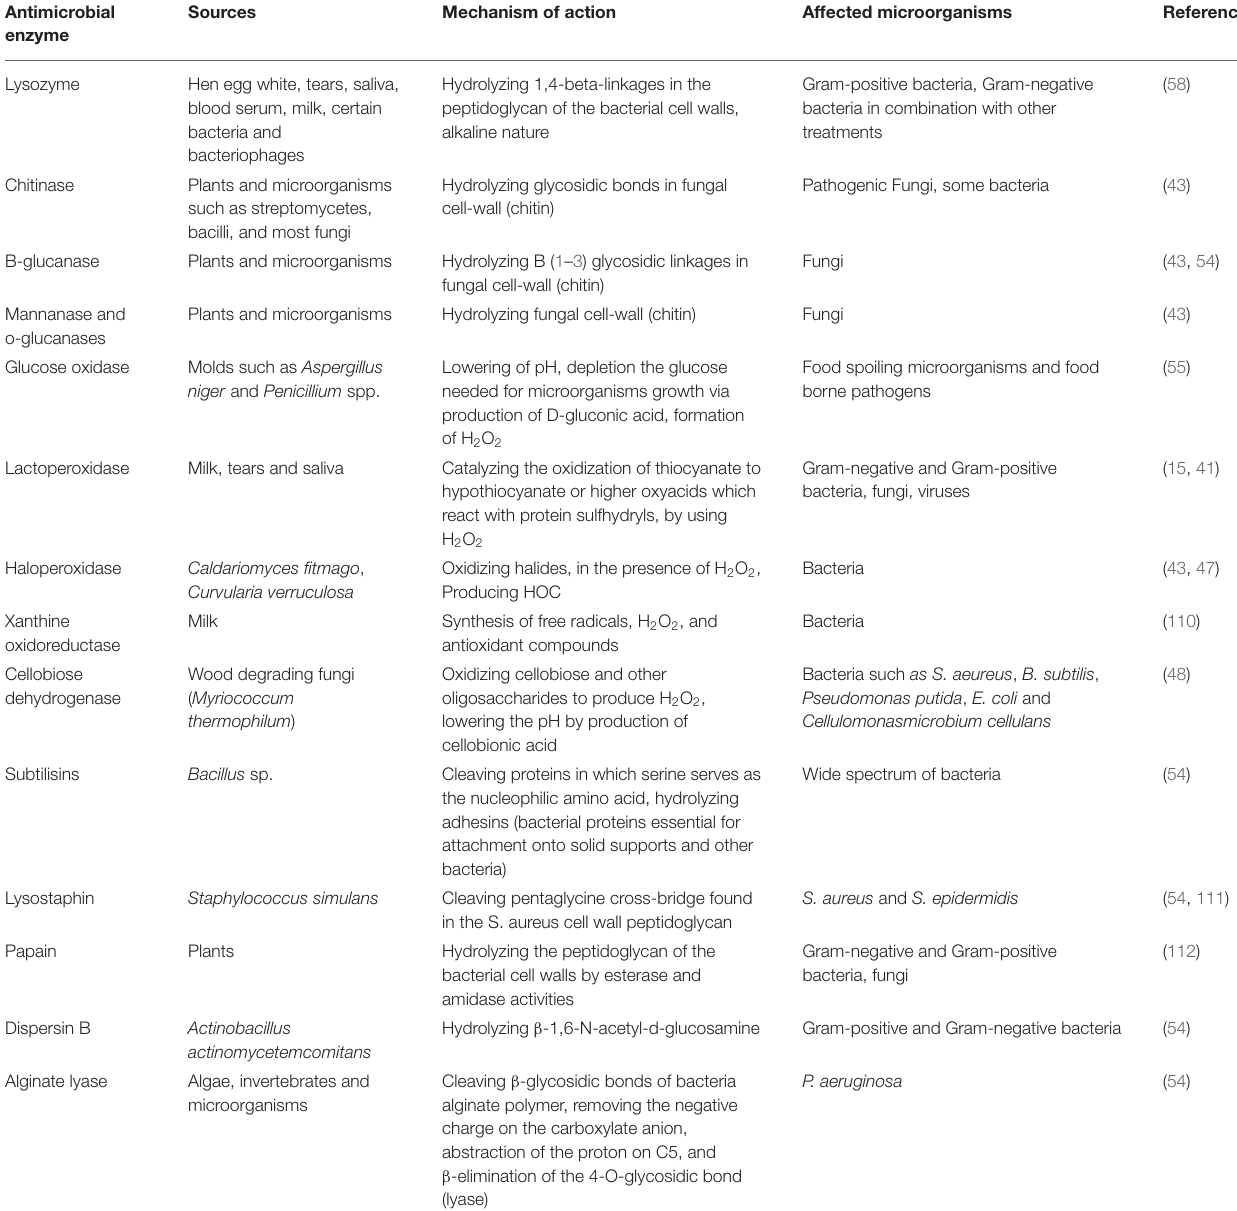
TABLE 1 | The mechanism of an antimicrobial activity of the most important enzymes. Antimicrobial